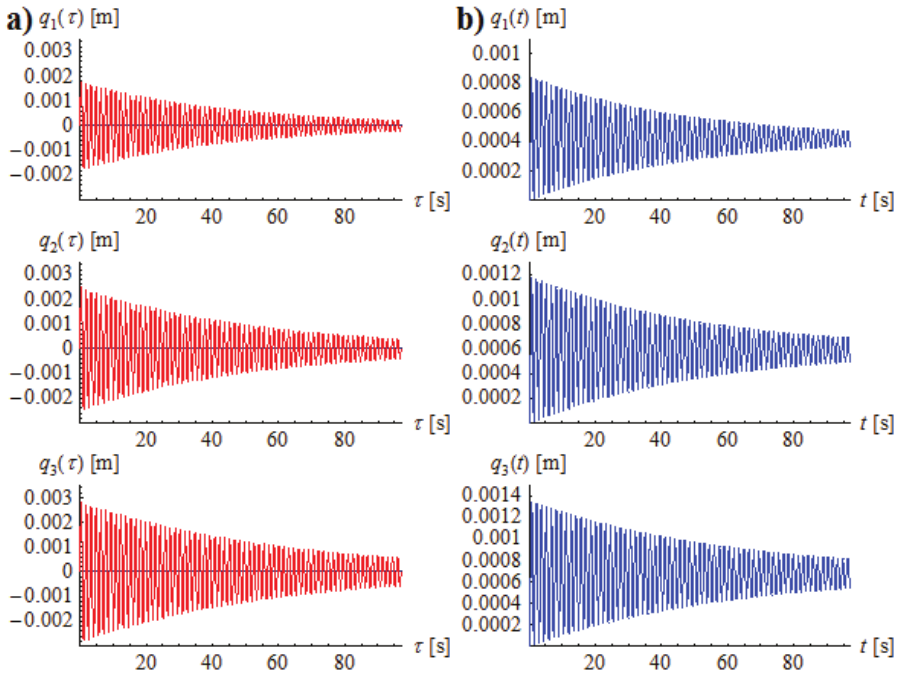
Figure 7: The results obtained from the third measurement: (a) displacement plots in the time domain t and (b) displacements determined in accordance with formula